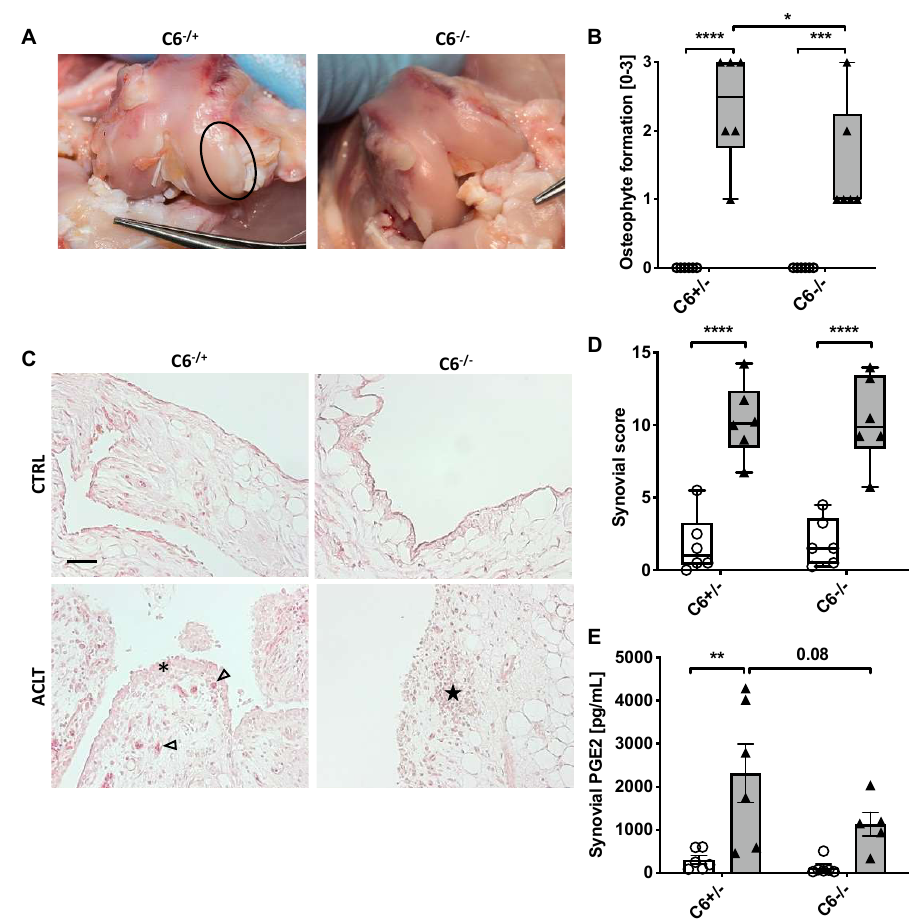
Figure 5. Evaluation of osteophyte formation and synovial inflammation. ( A ) Exemplary images of ACLT-operated joints after 8 weeks; macroscopic femoral osteophytes are indicated by a black circle. ( B ) Corresponding statistical analysis of macroscopically detectable osteophytes. ( C ) Exemplary images of Hematoxylin/ Eosin-stained synovial membrane of both experimental groups. Endothelial cells are indicated by black arrowheads; black asterisk indicates proliferation and hypertrophy of synoviocytes in lining layer; black star indicates lymphocyte aggregation; the black bar represents 50 µm. ( D ) Statistical analysis of the synovial score and ( E ) determination of synovial PGE2 concentrations. Data are charted as ( B,D ) box plots with median and whiskers min to max or ( E ) scattered bars with mean and SEM; white boxes/ bars= control joint, grey boxes/ bars= ACLT-operated joints. Statistically significant differences between groups ( n = 6 each) were depicted as: *: p ≤ 0.05, **: p ≤ 0.01, ***: p ≤ 0.001, and ****: p ≤ 0.0001. Pictures in (A) were modified from [20].